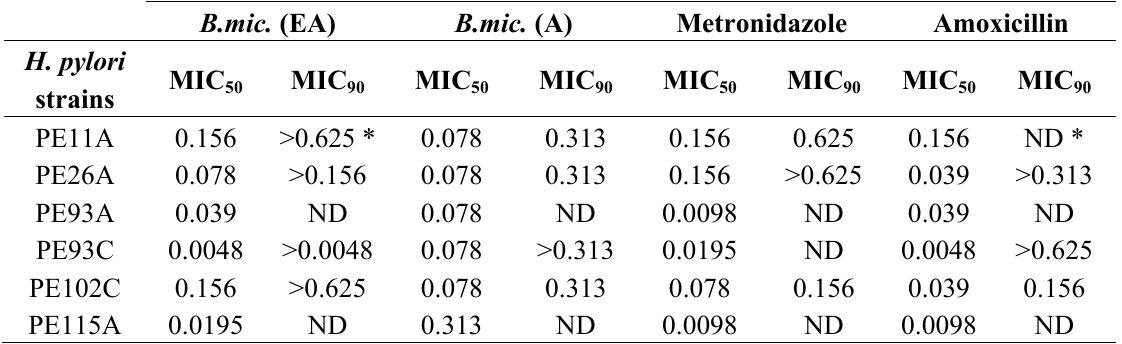
Table 3. In-vitro anti- H. pylori activities of B. micrantha ethyl acetate and acetone extracts and antibiotics at MIC and MIC (MIC 50 90